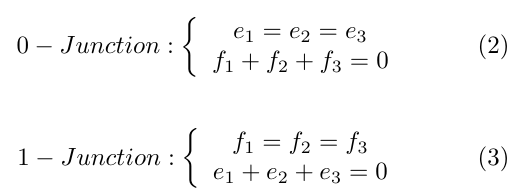
Figure 3: The two basic junctions. (a) 0-junction and (b) 1-junction The constitutive relations for 0-junction and 1-